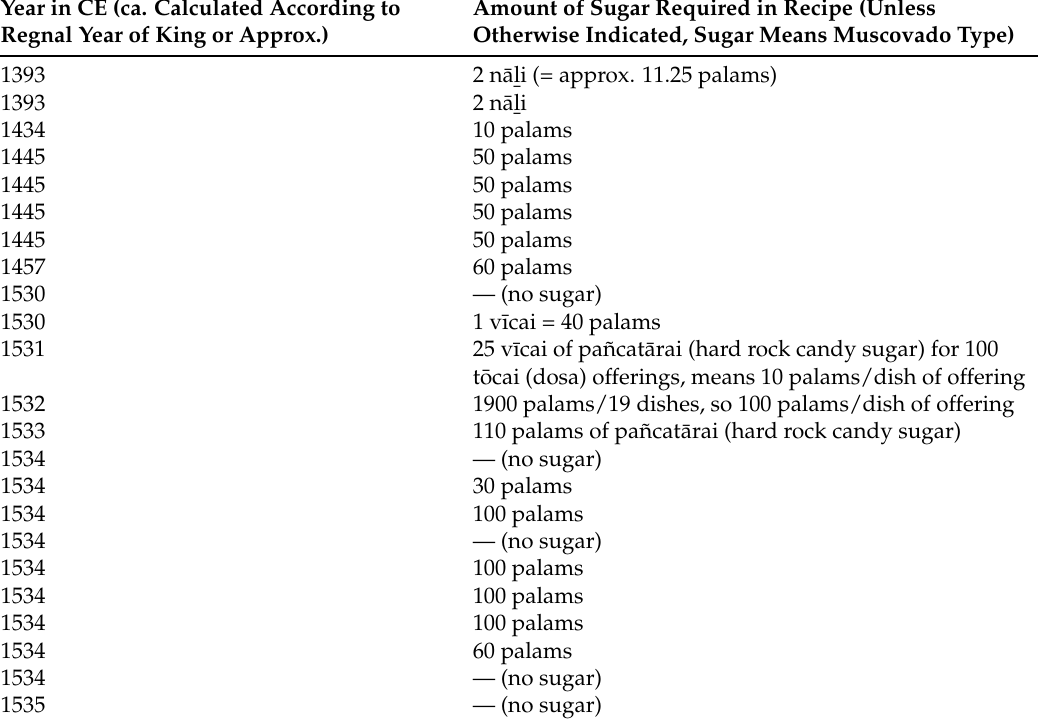
Table 5. Vijayanagara period data by inscription in chronological